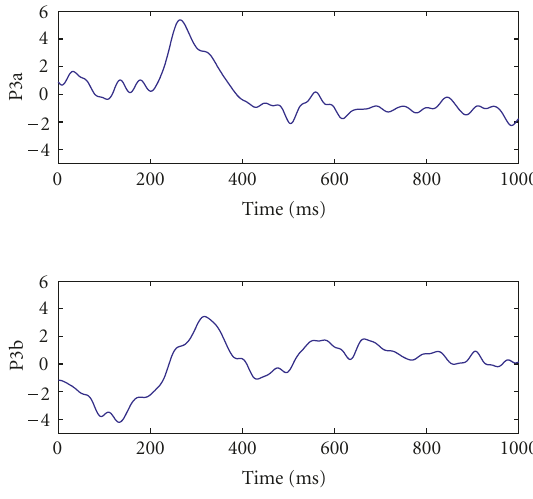
Figure 8: The separated P3a and P3b from the signals of Figure 7 using the proposed CBSS algorithms.